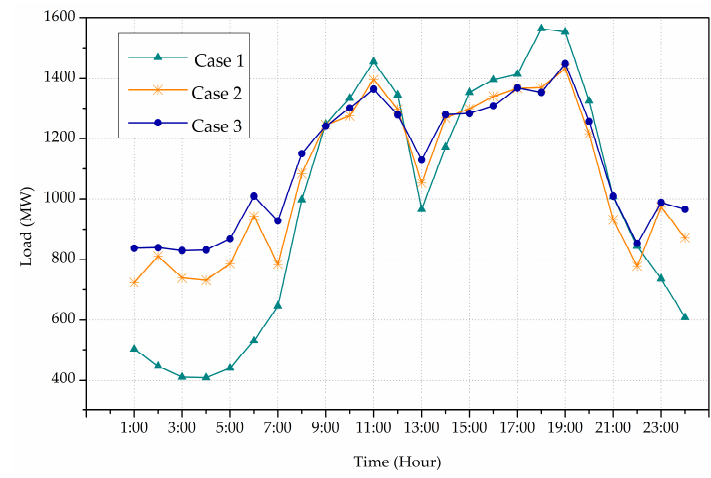
Table 4. Total daily load. Figure 5. Comparison of total load. Figure 5. Comparison of total load.